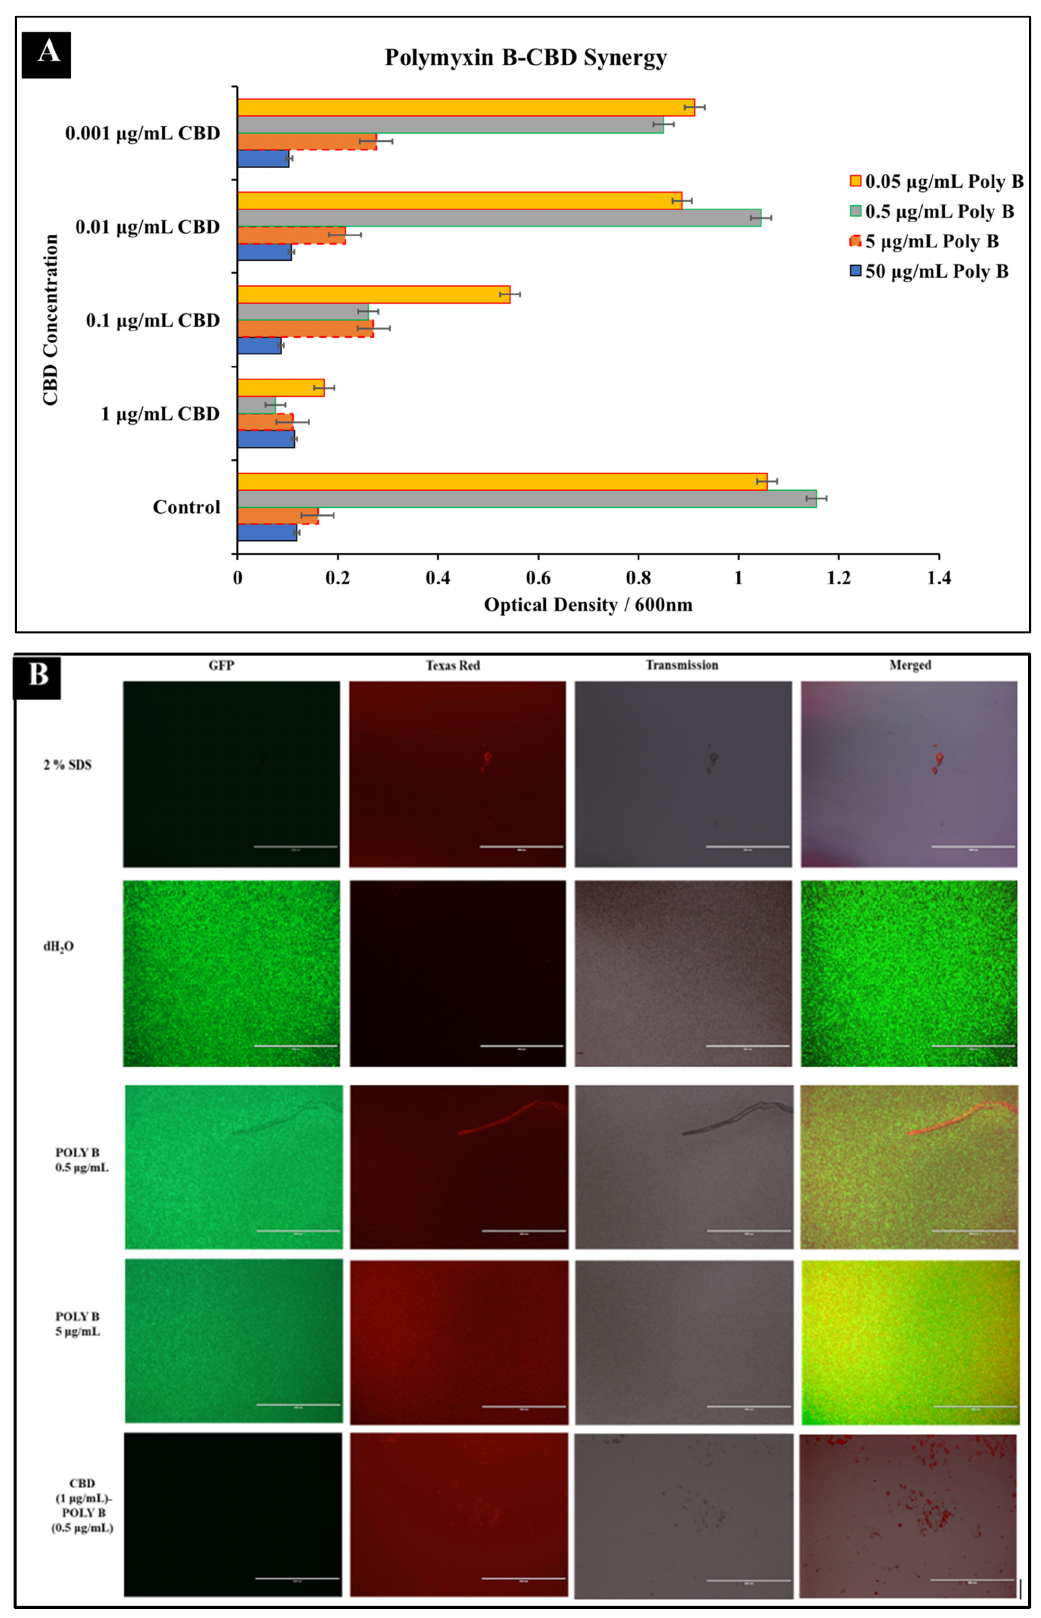
Figure 3. Synergistic analysis of polymyxin B and CBD co-treatment of S. typhimurium . ( A ) Potential synergistic activity was observed at 0.5 μ g/mL polymyxin B and 1 μ g/mL CBD co-treatment. Data presented as average OD 600 ± SEM. ( B ) Immunofluorescence staining analysis positive (2% SDS) and negative (dH 2 O) controls. Immunofluorescence staining of S. typhimurium treated with polymyxin B at 0.5 and 5 μ g/mL as well as the observed synergistic combination of 0.5 μ g/mL polymyxin B and 1 μ g/mL CBD.